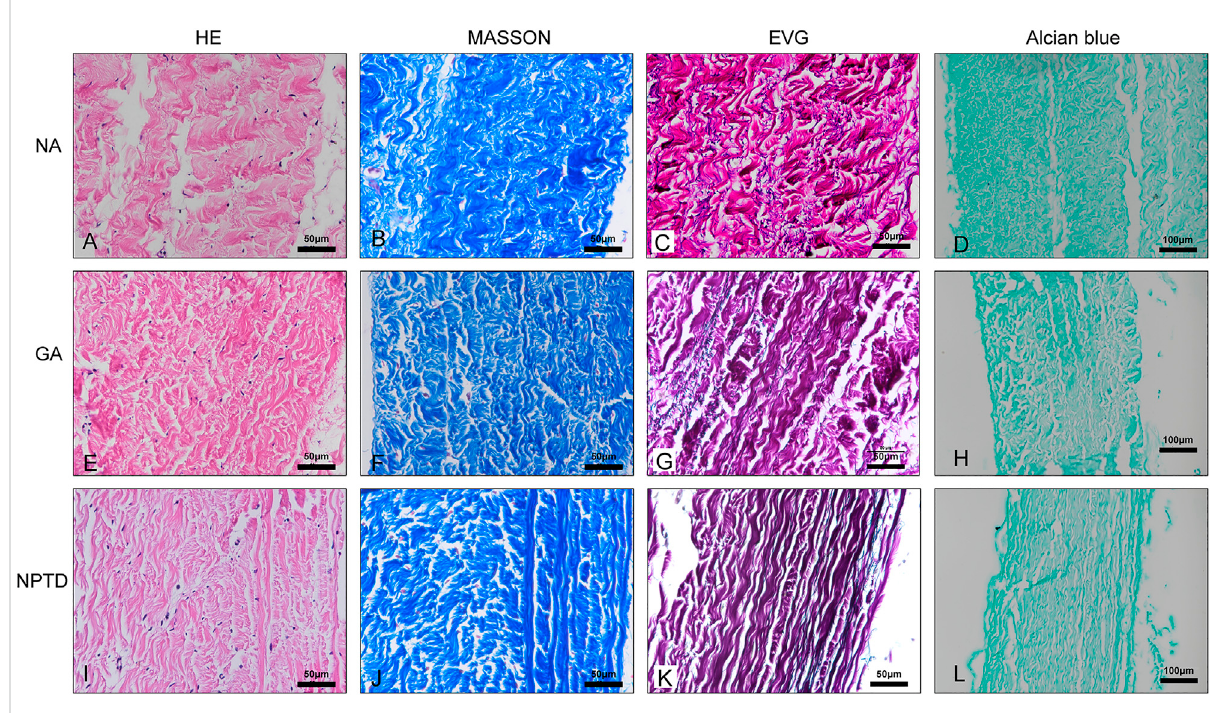
FIGURE 2 Histological staining images of the bovine pericardium. The structure of the lea fl ets remained intact and compact after the GA and NPTD crosslinked compared to the natural pericardium. The images show the HE staining (A,E,I) , Masson ’ s trichrome staining (B,F,J) , elastic Van-Gieson staining (C,G,K) and Alcian blue staining (D,H,L)